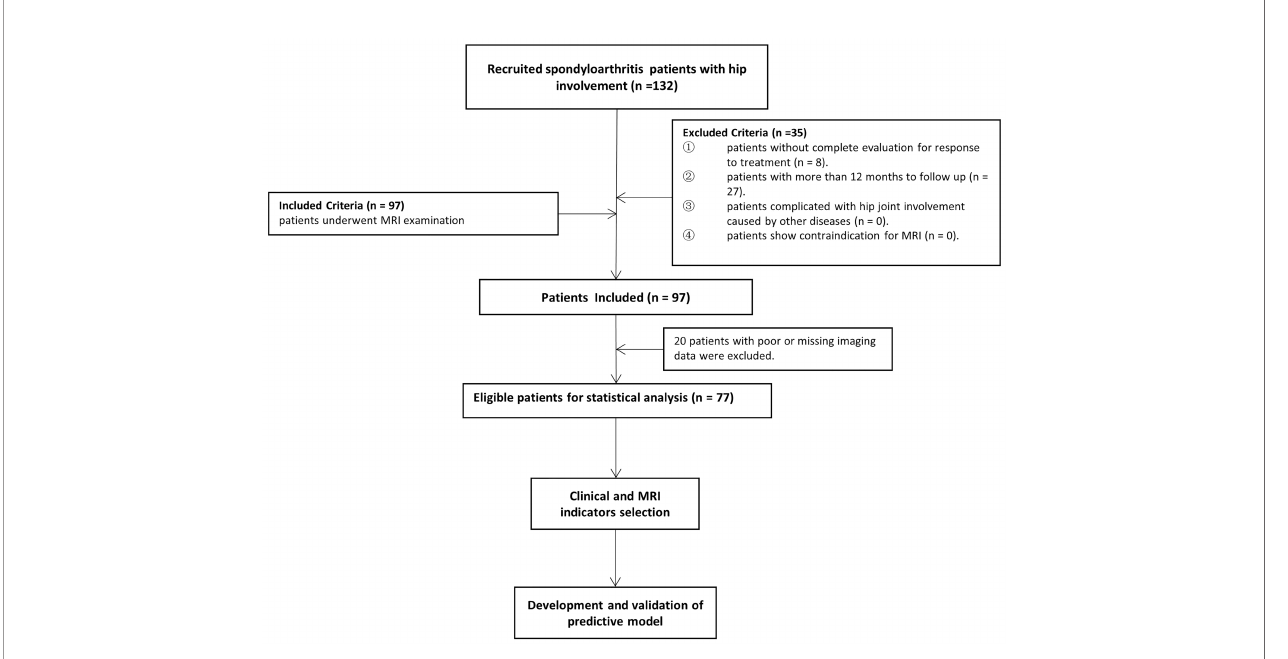
FIGURE 1 | Flow chart of patients enrolled in the